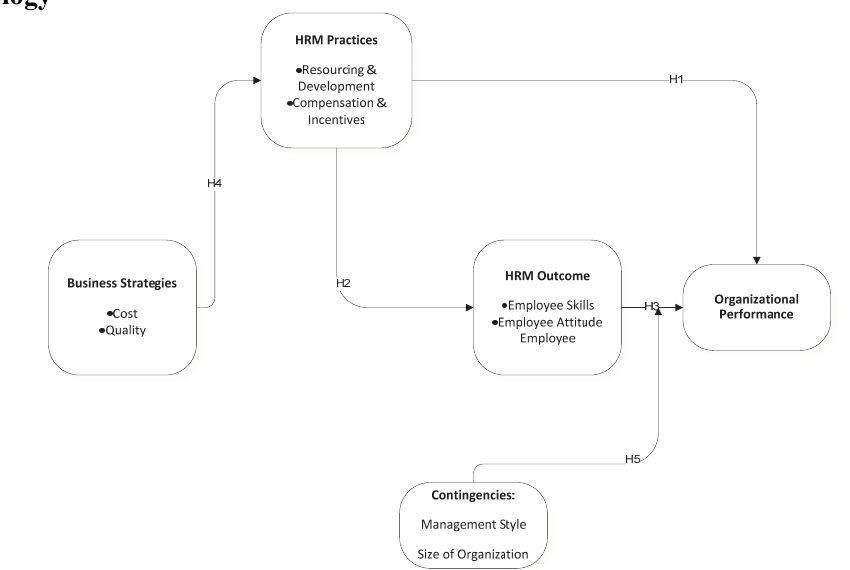
Fig. 1. Conceptual Framework (Based on Katou & Budhwar,